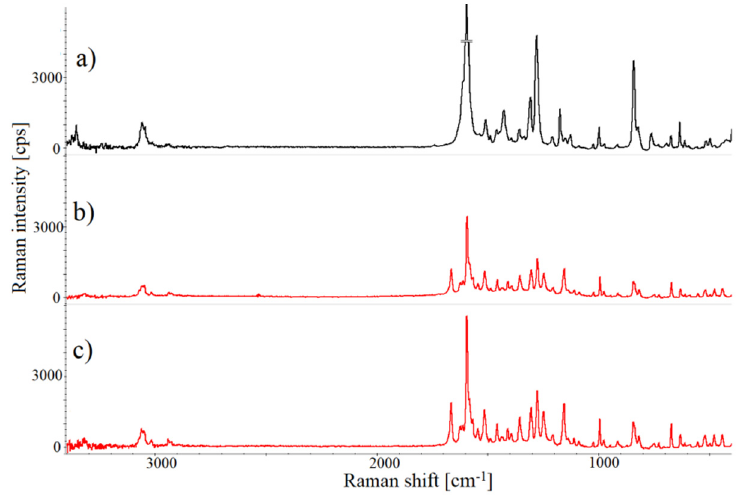
Figure 10. Raman spectra of: ( a ) chlordiazepoxide and p -aminobenzoic acid physical mixture, ( b ) chlordiazepoxide co-crystals with p -aminobenzoic acid prepared by grinding assisted acetonitrile, and ( c ) chlordiazepoxide co-crystals with p -aminobenzoic acid co-crystals prepared by slurry evaporation method and ethyl acetate as a solvent.